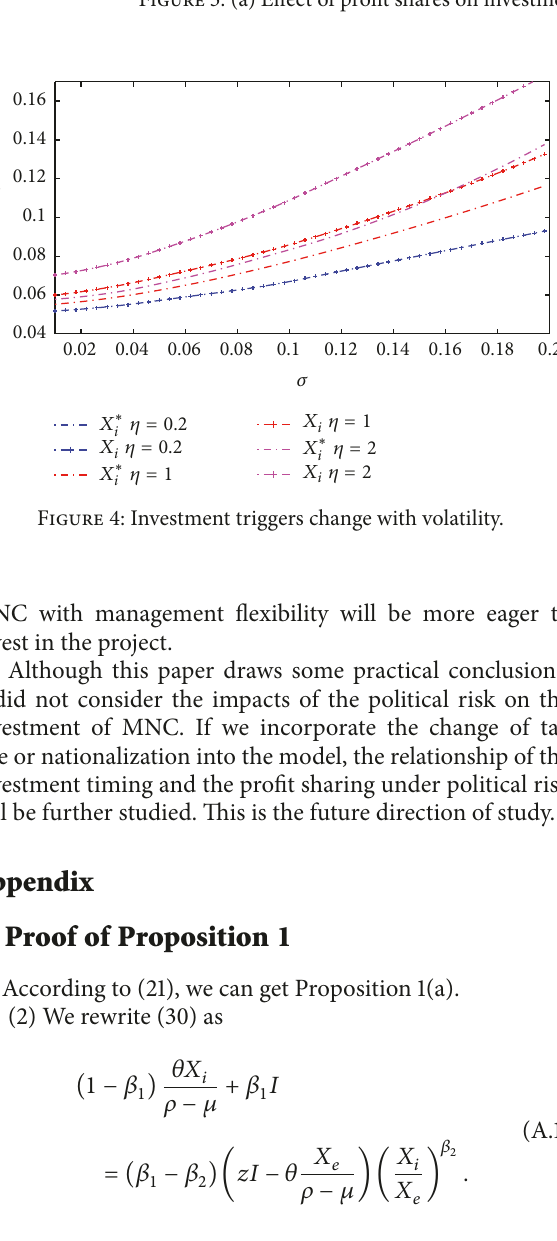
Figure 3: (a) Effect of profit shares on investment triggers. (b) Effect of profit shares on the difference.